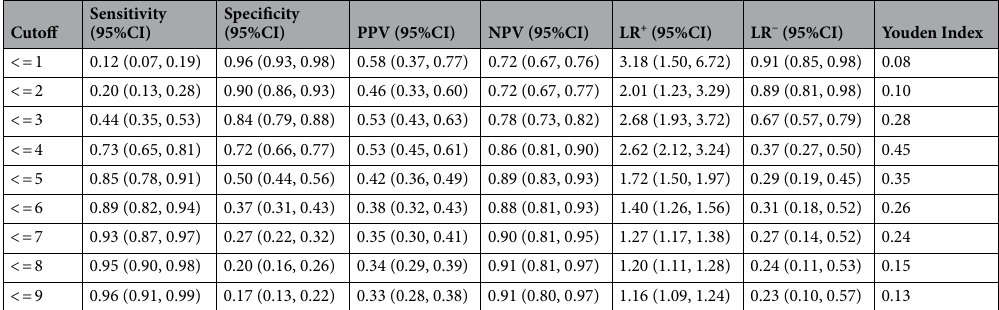
Table 2. Sensitivity, specificity, PPV, NPV, LR + , and LR − of MDD-W score among PLHIV in all ART clinics of Bahir Dar, 2017.